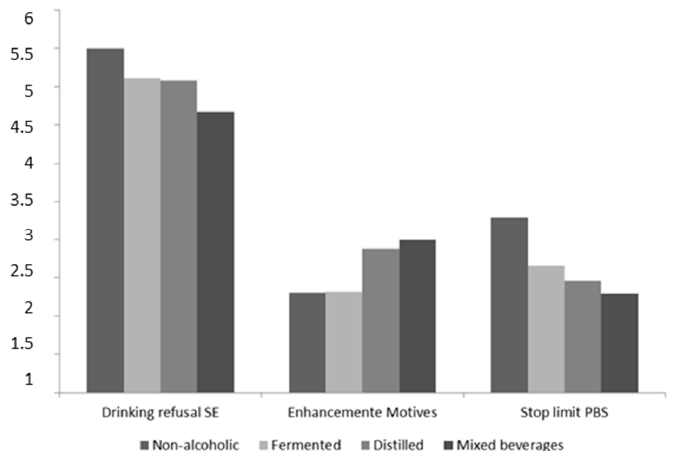
Figure 2. Differences in the type of beverages consumed in function of the psychosocial variables studied (drinking refusal self-efficacy, enhancement motives and protective behavioral strategies).